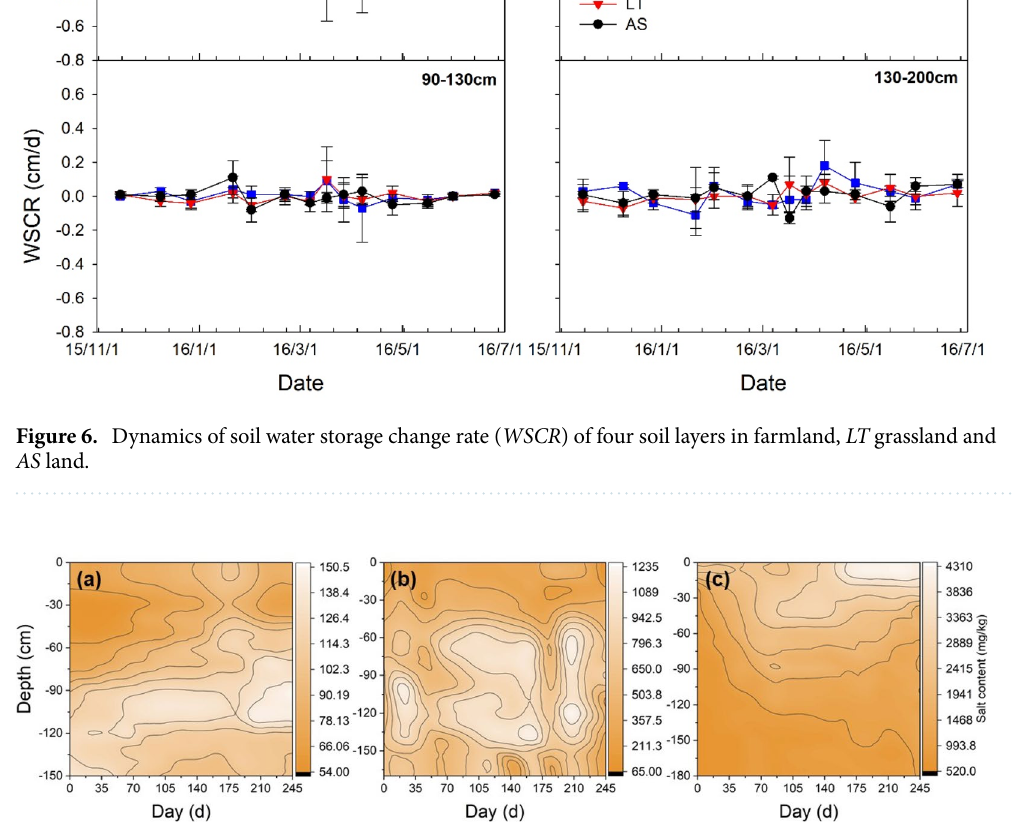
Figure 7. Contour map of soil salt content in farmland ( a ), LT grassland ( b ) and AS land ( c ) from 24 October, 2015 to 25 June,